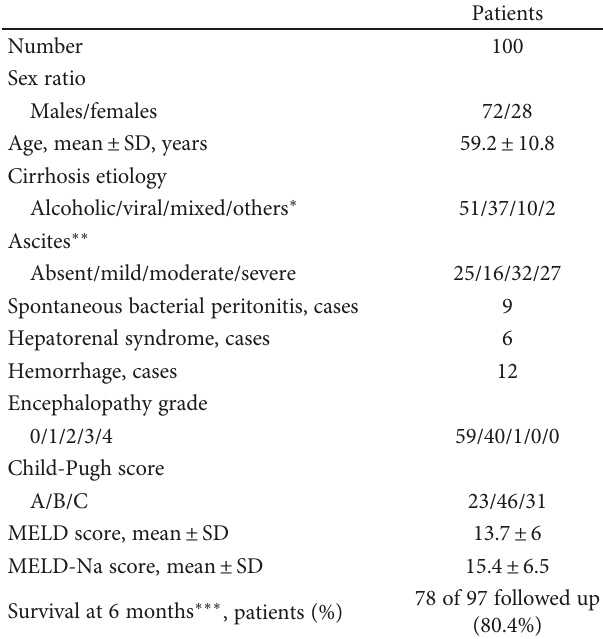
Table 1: Demographic, severity, and survival data of included